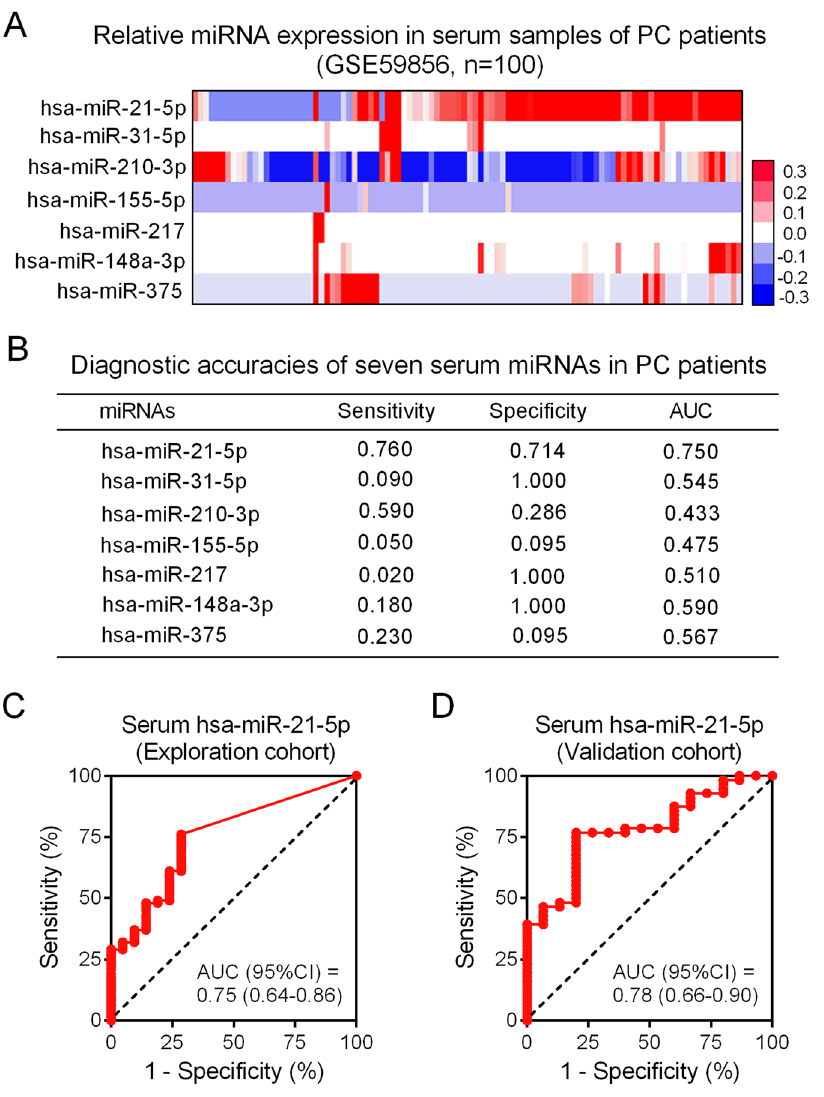
Figure 5. The expression and diagnostic accuracy of hsa-miR-21-5p in serum samples. ( A ) The expression alteration of seven meta-signature miRNAs in serum samples (GSE59856). ( B ) Diagnostic test of each meta- signature miRNA by using dataset GSE59856. ( C ) and ( D ) Receiver operating characteristic (ROC) curve was conducted to evaluate the diagnostic accuracy of serum hsa-miR-21-5p in GSE59856 dataset and our validation group. PC: pancreatic cancer; Sen, sensitivity; Spec, specificity; AUC, area under ROC